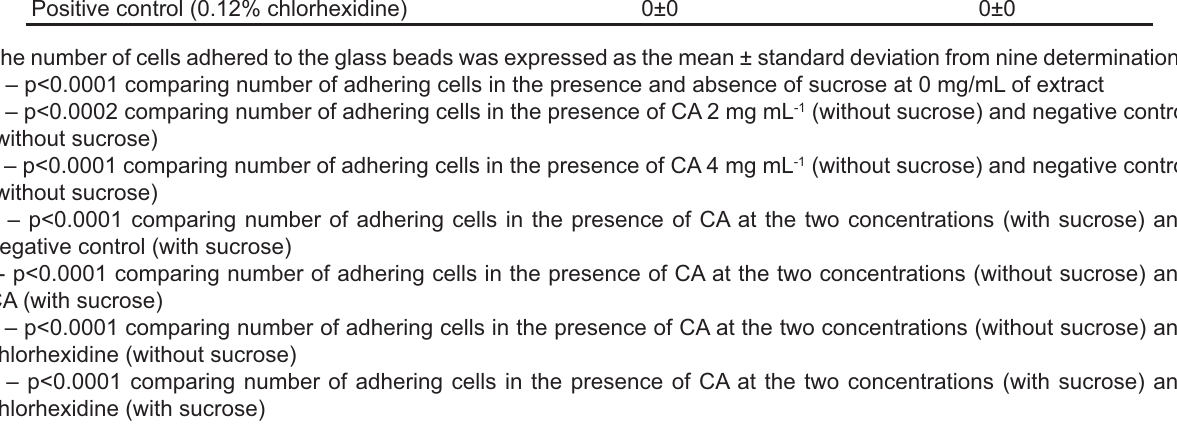
The number of cells adhered to the glass beads was expressed as the mean ± standard deviation from nine determinations